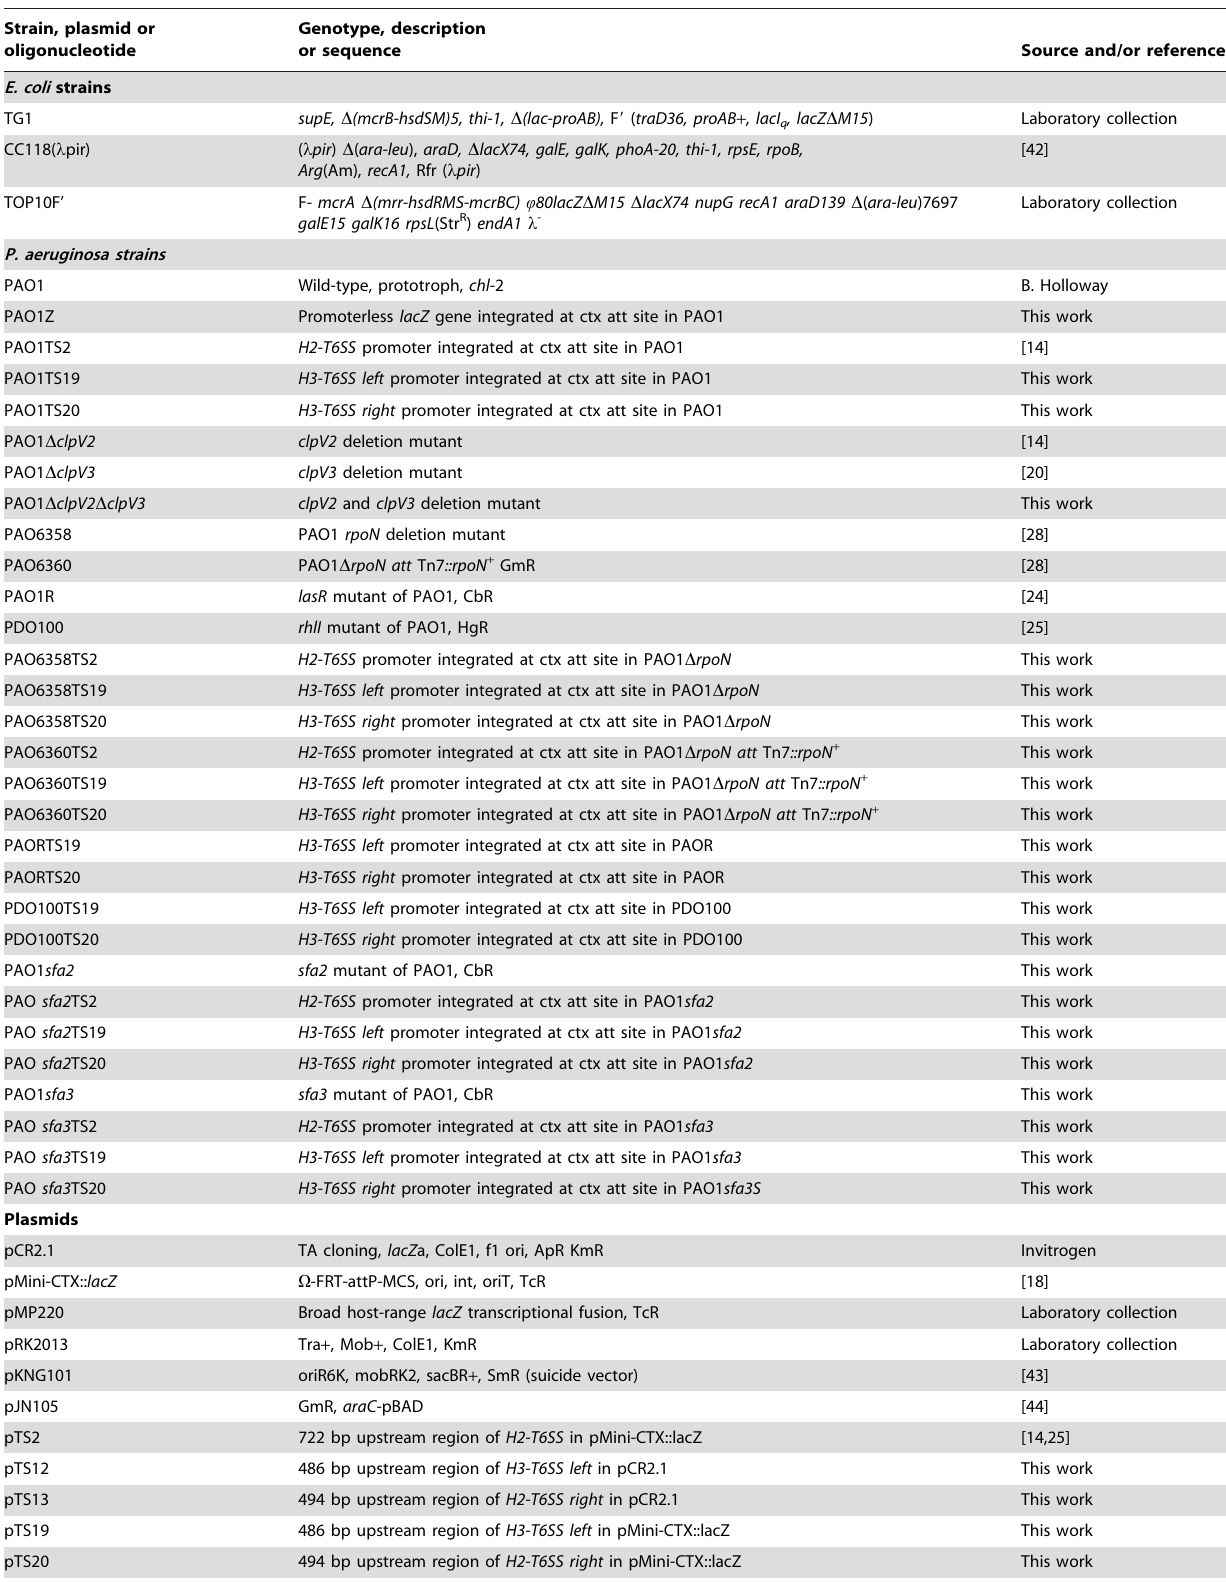
Table 1. Strains, plasmids and oligonucleotides used in this study.